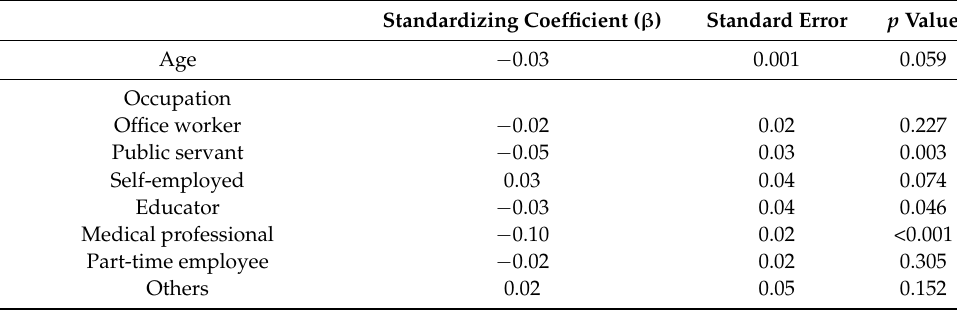
Table 5. Characteristics of pregnant who women use social